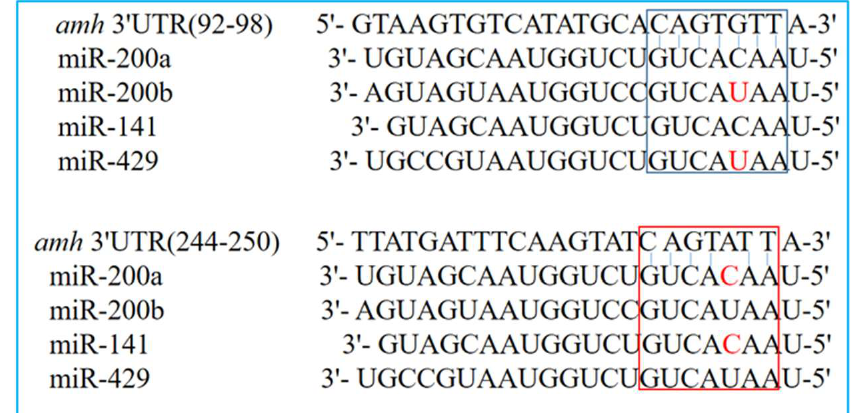
Figure 2. The prediction of the target site between the miR-200 family and amh gene. Site 1 in the top square: the site where miR-200a and miR-141 are entirely complementary; site 2 in the bottom square: the site where miR-200b and miR-429 are entirely complementary. The squares represent complementary seed sequences at positions 2 to 8. The red letters are not complementary nucleotides.